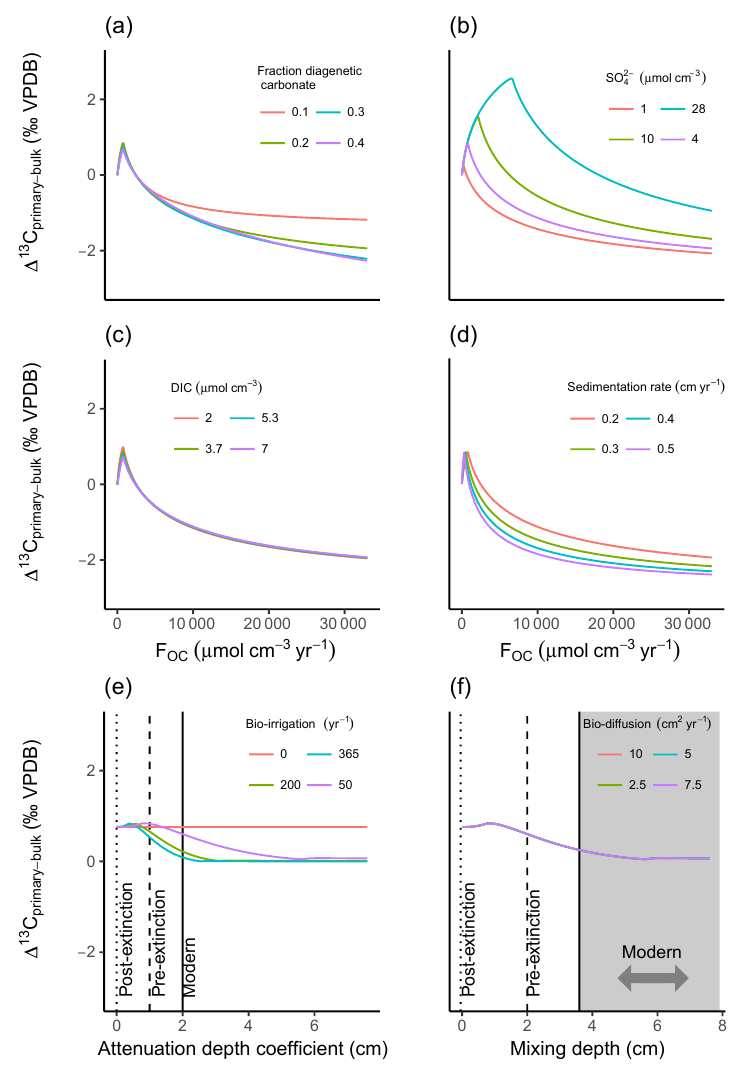
Figure 5. Sensitivity experiment for diagenetic carbonate alteration through equilibrium recrystallization with depth designed to investigate the forcing effect of (a) the fraction of diagenetic carbonate incorporated ( f dia ), (b) sulfate content of overlying water, (c) DIC content of over- lying water and (d) sedimentation rate ( v and w ) on the carbon isotope offset between the diagenetic end-member rock and the primary calcite over a range of F OC . Panels (e) and (f) depict sensitivity experiments for bio-irrigation ( α 0 ) and bio-diffusion ( D b0 ), respectively, on diage- netic altered carbonate for changing modes of sediment reworking and irrigation by biota under a normal OC flux (730µmolcm − 3 yr − 1 ). An increasingly suppressed alteration of the end-member carbon isotope signal is observed for the pre-extinction (Dale et al., 2016) and modern (van de Velde and Meysman, 2016) depth profiles compared with sediment that is not inhabited by metazoans